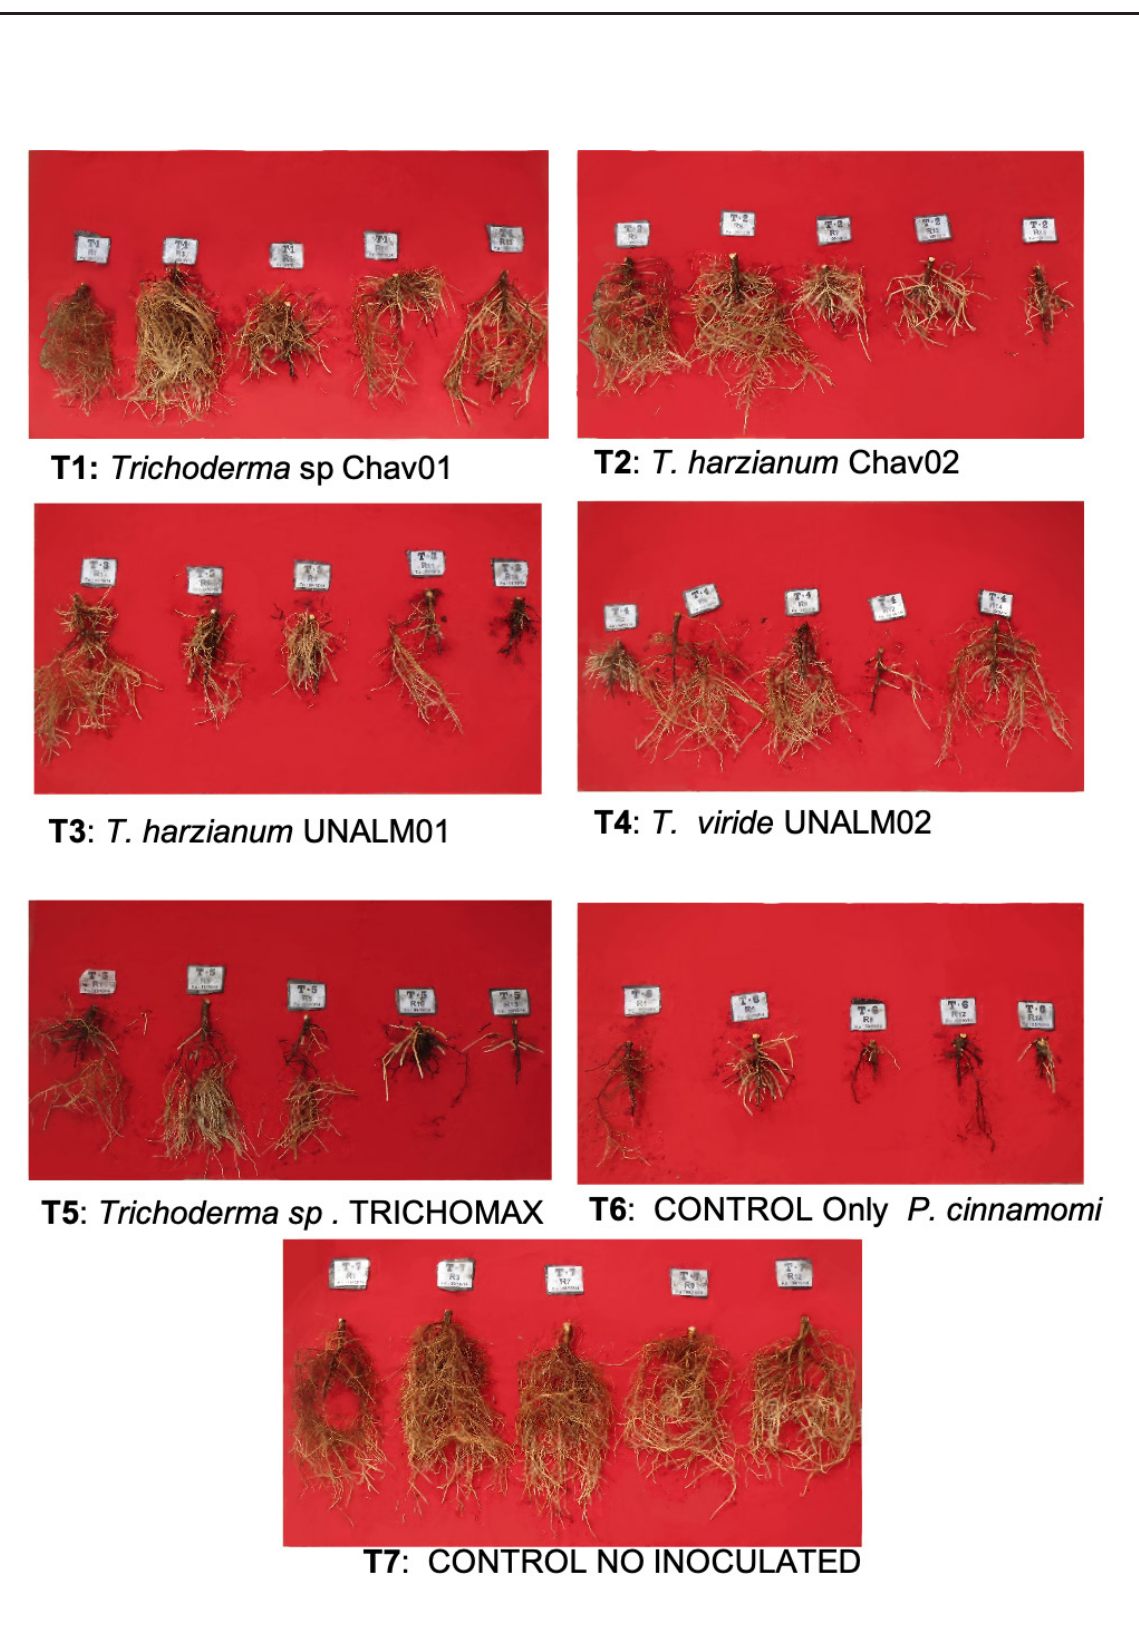
Fig. 4. Roots of Zutano avocado inoculated with Phytophthora cinnamomi and treated with different Trichoderma